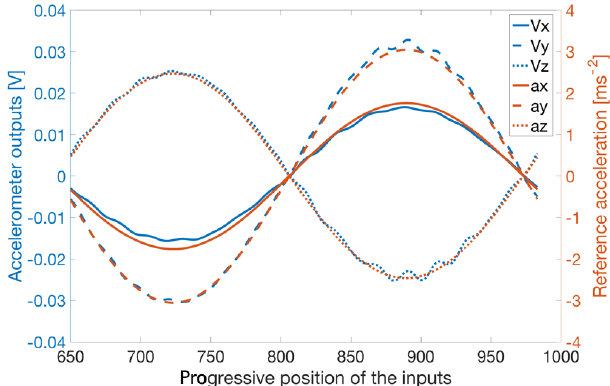
Figure 2. Time behaviour of accelerometer outputs and reference inputs: